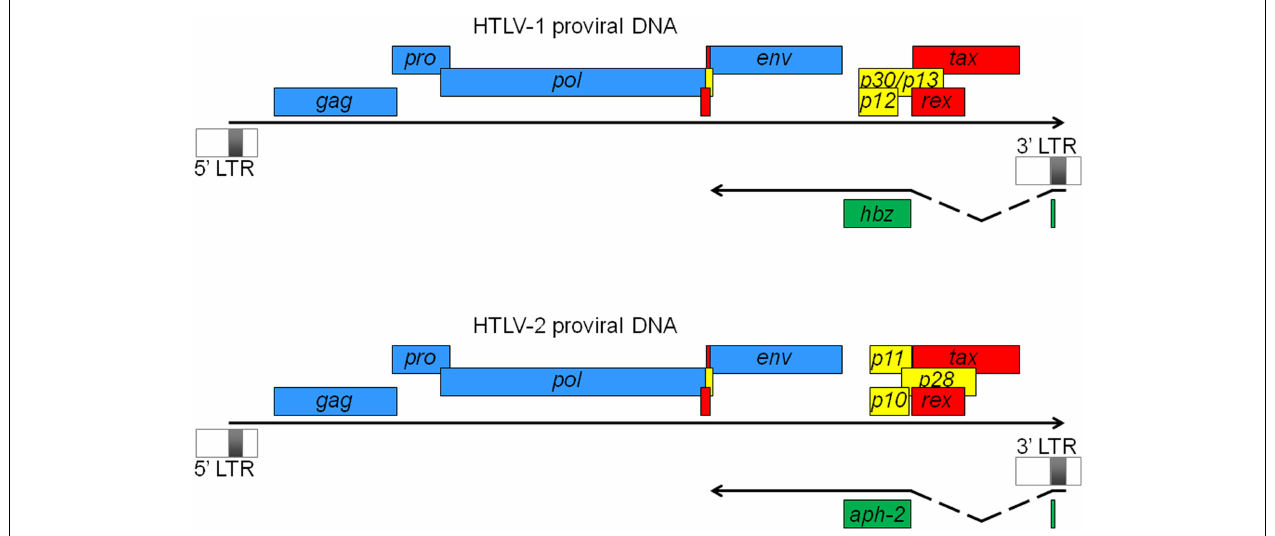
a similar position in the 3 (cid:2) LTR (which constitutes the first exon) and are spliced to the second exon, which contains the main ORF region as well as the 3 (cid:2) untranslated region.Their polyA tail is positioned 1450 nucleotides from the ORF stop codon. In HTLV-1, an unspliced transcript initiating downstream of the 3 (cid:2) LTR (not shown here) has also been described (Yoshida etal.,